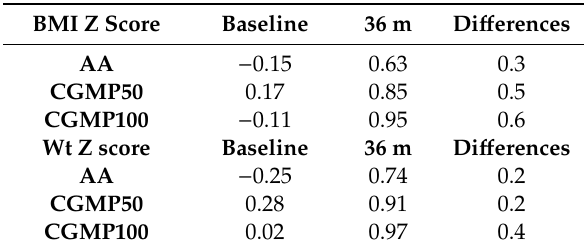
Table 6. Change in weight and BMI Z scores from baseline to year 3 in the AA, CGMP50 and CGMP100 groups applying ANCOVA adjusting for variables in age and gender di ff